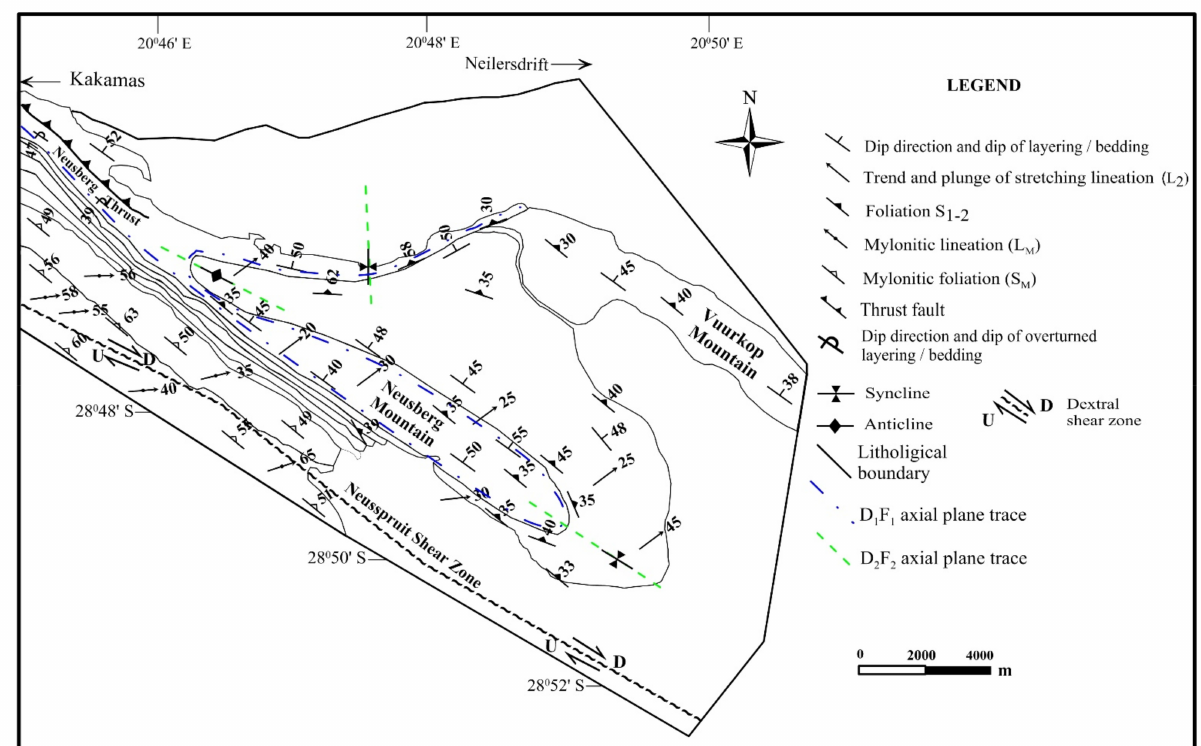
Figure 6. Morphological and geometrical illustration of the Neusberg macrofold in the Kakamas Domain showing the north-westerly trending Neusberg thrust and Neusspruit shear zone. General geometric data of co-planar F 1 /F 2 folds are supplied in Figure